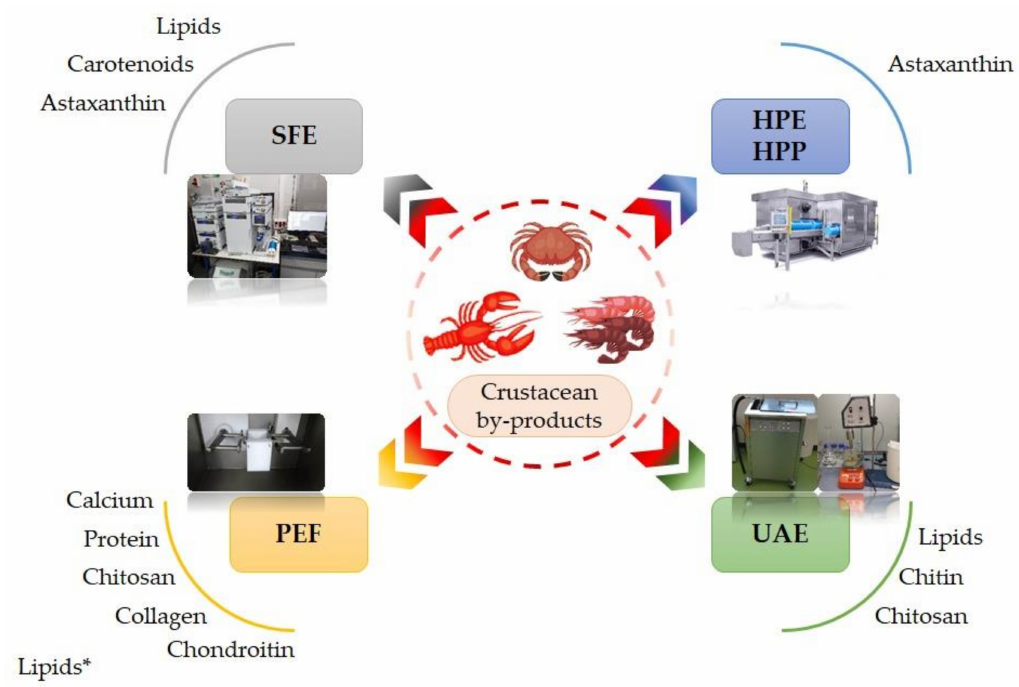
Figure 4. Main compounds extracted using non-thermal technologies. SFE: Supercritical Fluid Extraction; HPE: High- Pressure Extraction; HPP: High-Pressure Processing; PEF: Pulsed Electric Fields; UAE: Ultrasounds Assisted Extrac- tion. * = used as a pre-treatment. The HPE/HPP picture was obtained from HIPERBARIC (Burgos, Spain) and used with